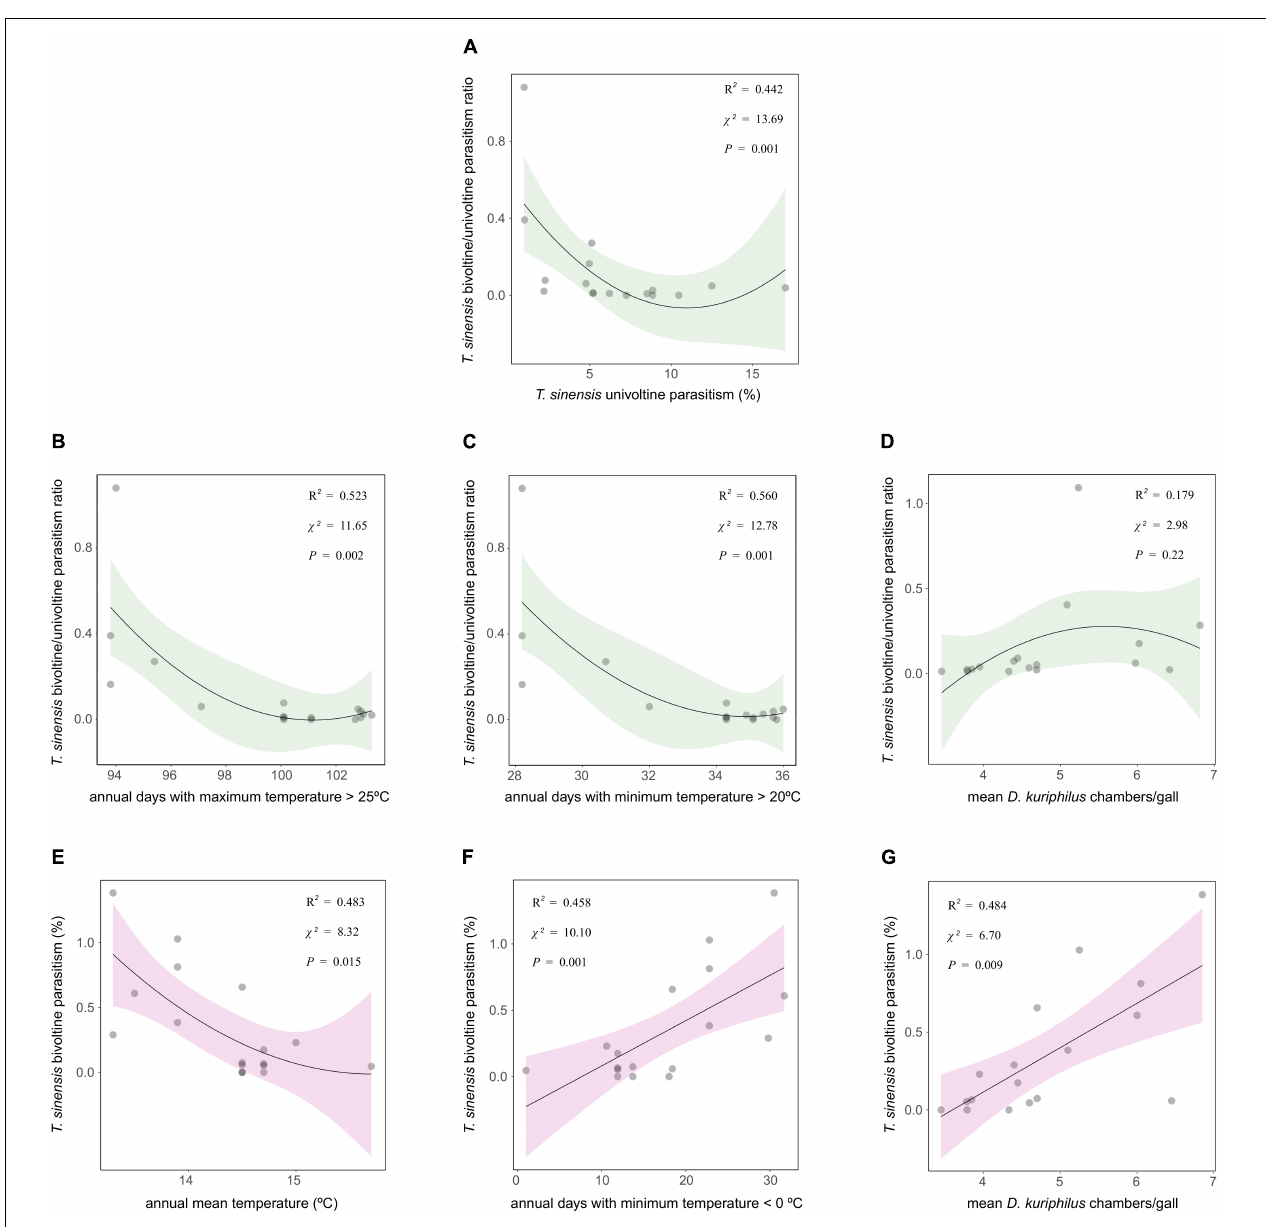
FIGURE 2 | Linear/quadratic functions (plural) of (A) T. sinensis univoltine parasitism, and (B–G) temperature measurements and mean D. kuriphilus chambers/gall on T. sinensis bivoltine/univoltine parasitism ratio and T. sinensis bivoltine parasitism. χ 2 and P -values extracted from spatially explicit regression models; explained variance ( R 2 ) extracted from models without spatial autocorrelation